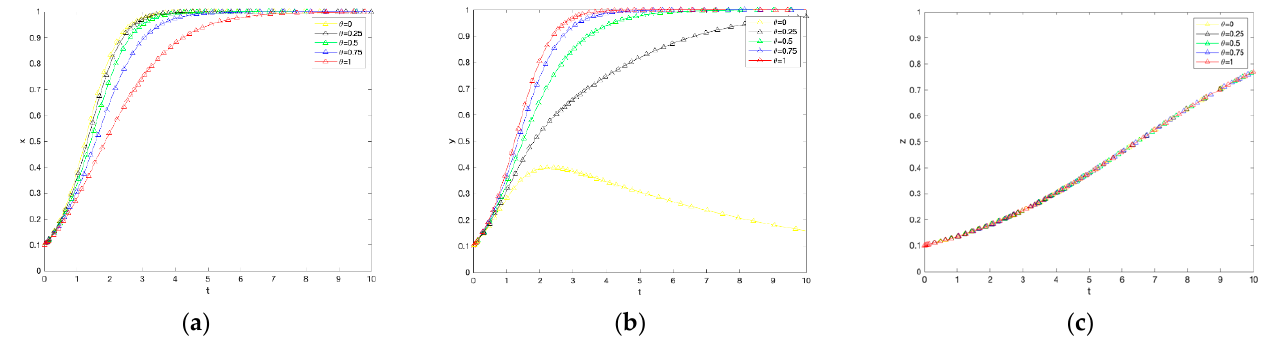
Figure 2. The impact of changes in government subsidy coefficients on government subsidies, farmer adoption, and consumer purchases. ( a ) Government response. ( b ) Farmers’ response. ( c ) Consumer